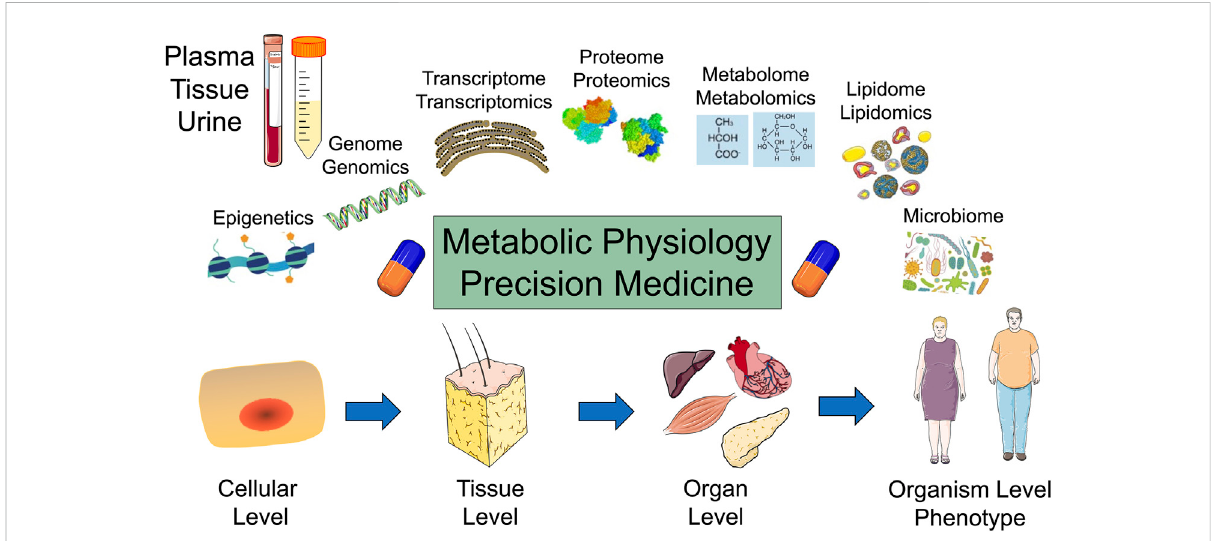
FIGURE 1 Metabolic physiology and the promise of precision medicine: Top: Plasma, tissue, and urine samples are analyzed for epigenetics, genomics, transcriptomics, proteomics, metabolomics, lipidomics, and microbiome. Bottom: Metabolism is evaluated at the cellular, tissue, organ, and organism